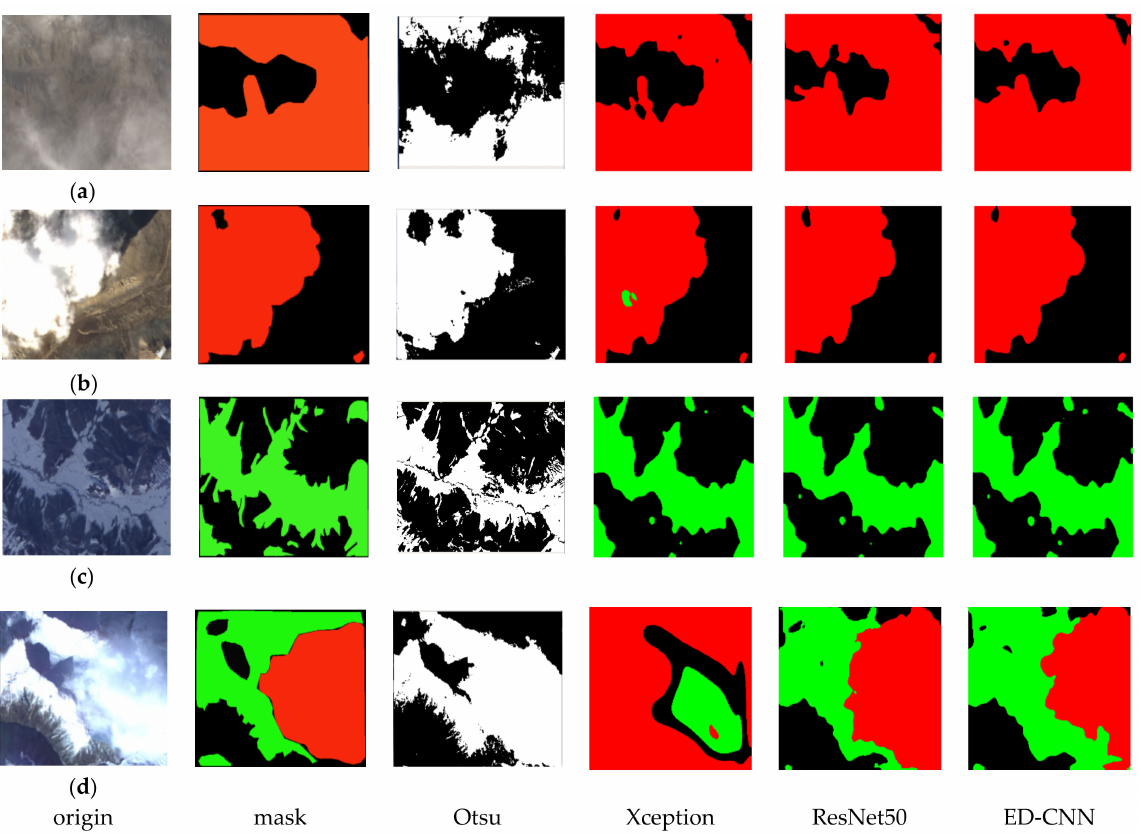
Figure 9. Testing results of the proposed method on the TH-1 image acquired from different temporal